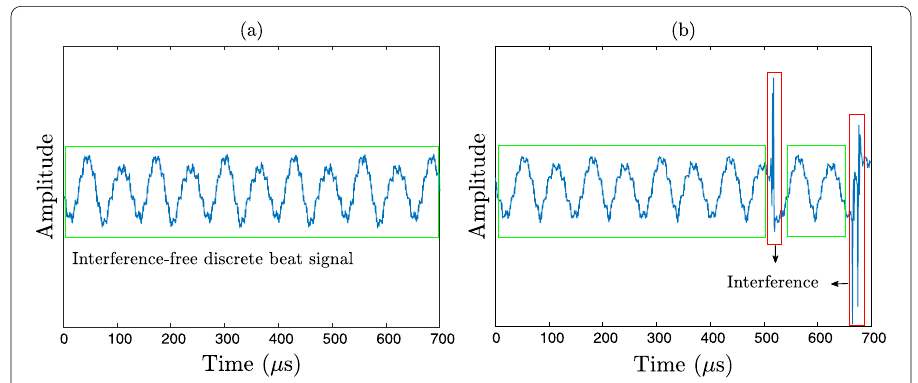
Fig. 1 Example of a discrete beat signal without ( a ) and with ( b )